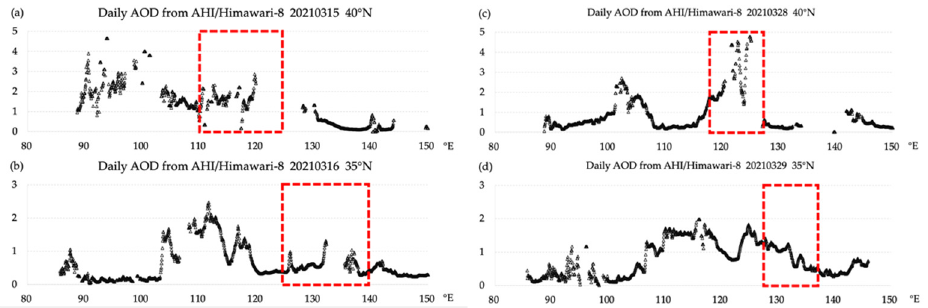
Figure 4. Daily average 500 nm AOD from AHI/Himawari-8. AOD values were 25-point moving average on cross-section of ( a ) 15 March at 40°N, ( b ) 16 March at 35°N, ( c ) 28 March at 40°N, ( d ) 29 March at 35°N.